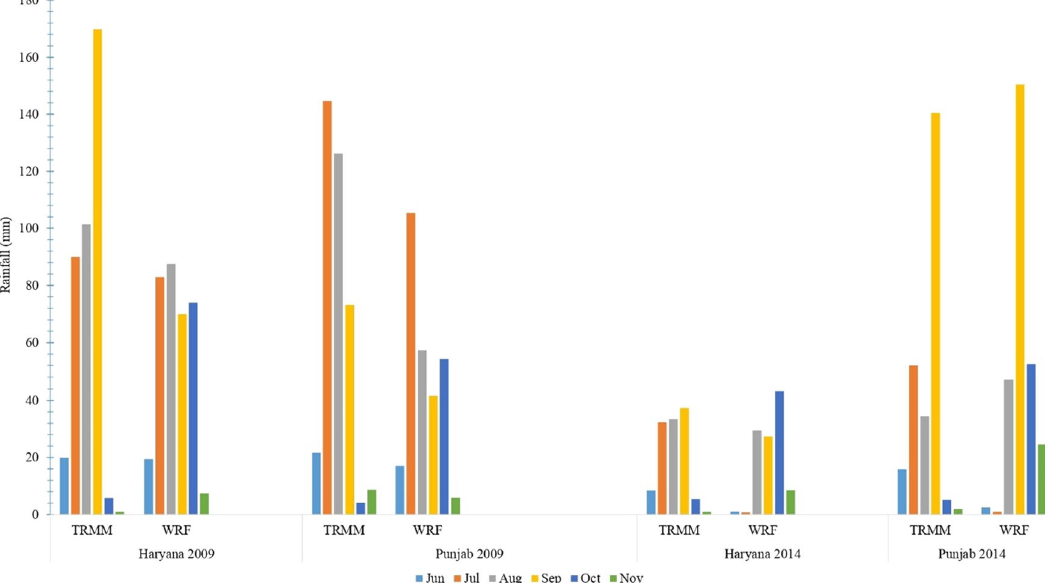
Figure 7. Comparison between simulated and observed monthly rainfall time series provided by the WRF model and the TRMM dataset, respectively, for Jun-Nov in Haryana and Punjab during 2009 and